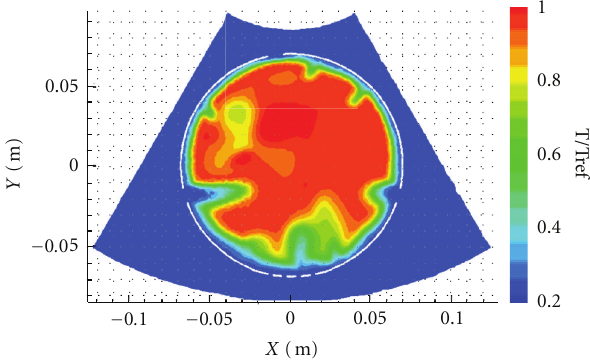
Figure 11: Temperature at the second primary hole cross-section.